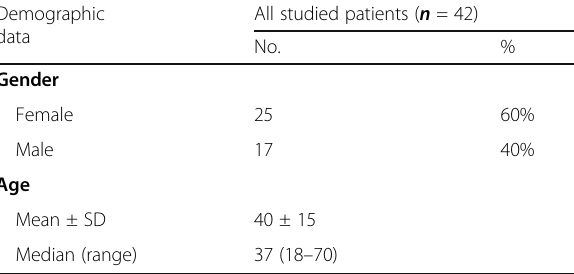
Table 2 Demographic data of the studied patients (No. = 42) Demographic